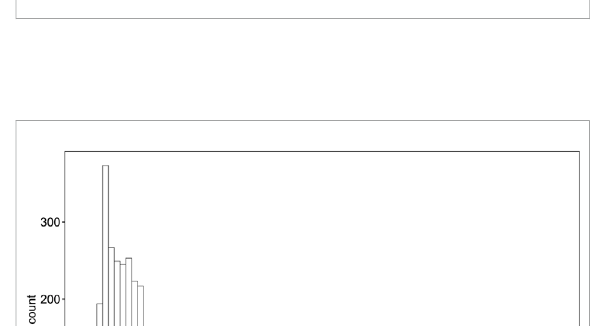
FIGURE 1 Frequency statistics of three sequence environments methylated cytosine. Different color of the bar represents the sequence environment of methylated cytosine.